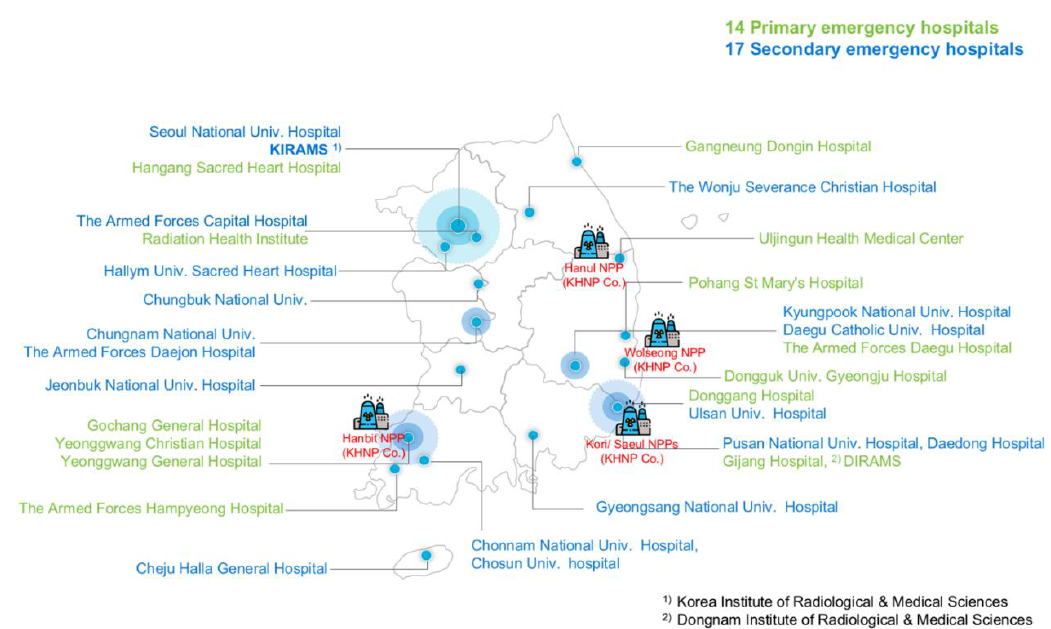
Figure 1. Radiation emergency medicine hospital network and nuclear power plant (NPP) in South Korea (as of June 2021). This network consists of 14 primary emergency hospitals and 17 secondary emergency hospitals, with the National Radiation Emergency Medical Center (NREMC) as the control center. The figure is modified from the available data on the website [9].